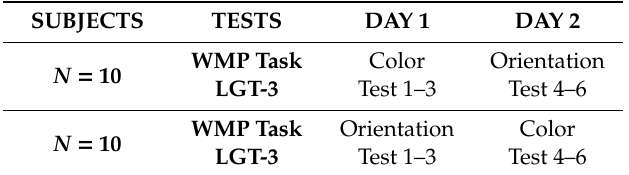
Table 1. Overview of experimental procedure. WMP, working memory precision; LGT-3, Lern und Gedächtnistest 3. SUBJECTS TESTS DAY